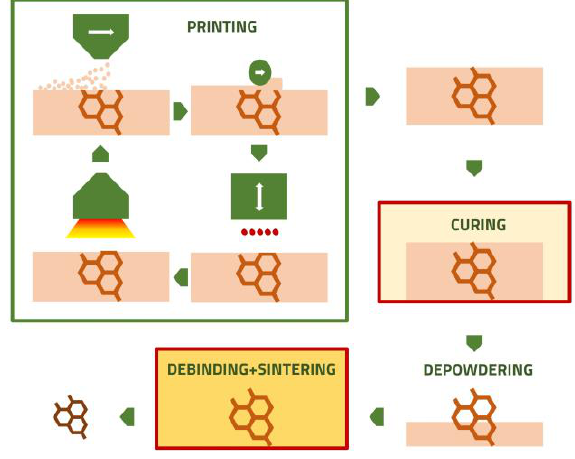
Figure 1. Scheme of the different steps of printing process (powder spreading, binder deposition and drying) and secondary operations: curing, de-powdering, de-binding and sintering.